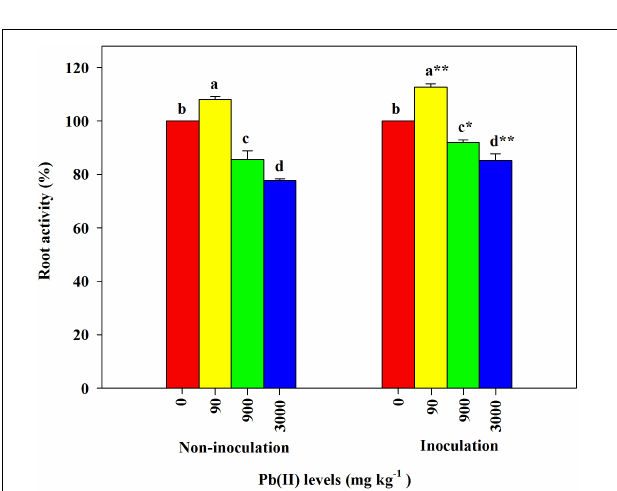
FIGURE 3 | Relative changes in root activity of Robinia pseudoacacia seedlings grown with or without Funneliformis mosseae and subjected to different Pb levels for 4 months. Shown are means ± SD ( n = 3). Asterisks indicate significant differences between inoculated and non-inoculated seedlings within each Pb treatment ( ∗ P < 0.05, ∗∗ P < 0.01; t -test). Different lowercase letters indicate significant differences among different Pb levels within inoculated or non-inoculated treatment ( P < 0.05; ANOVA with post hoc